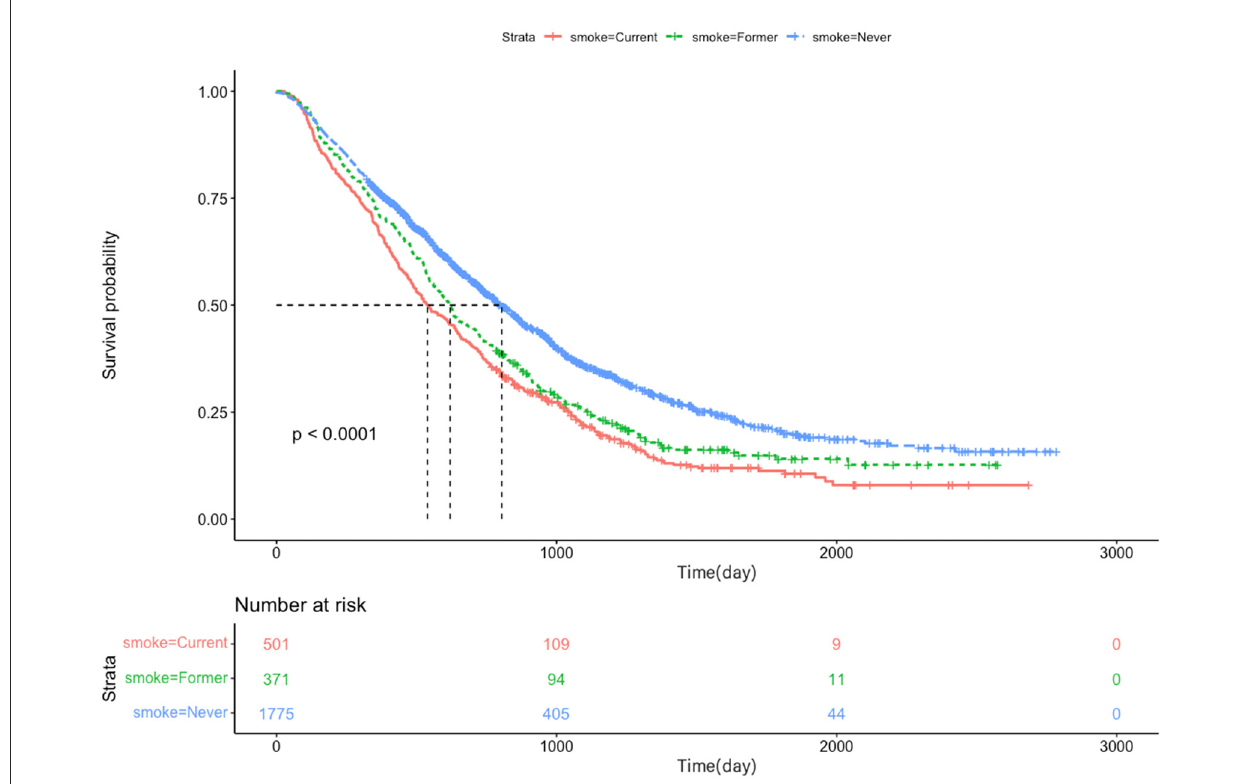
FIGURE2 Kaplan–Meier plots of overall survival for lung cancer patients with brain metastases based on smoking status.